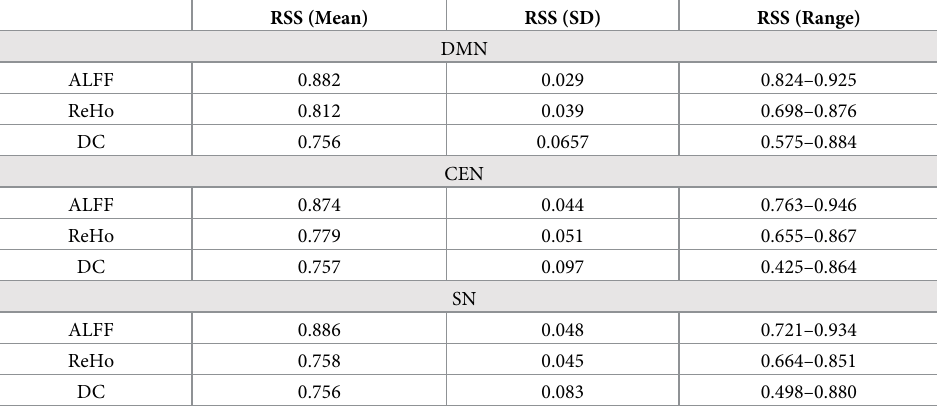
Table 3. Mean values, standard deviation, and the range of the resting-state similarity (RSS) calculated separately for each resting-state fMRI parameter (ALFF, ReHo, and DC) and for each of the triple networks (default